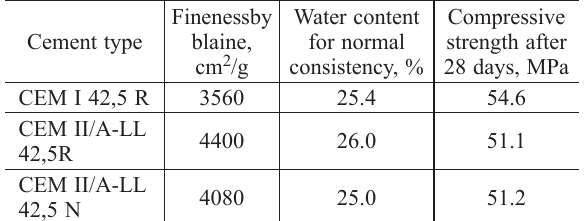
Fig. 2. Shear rates during testing vs testing time